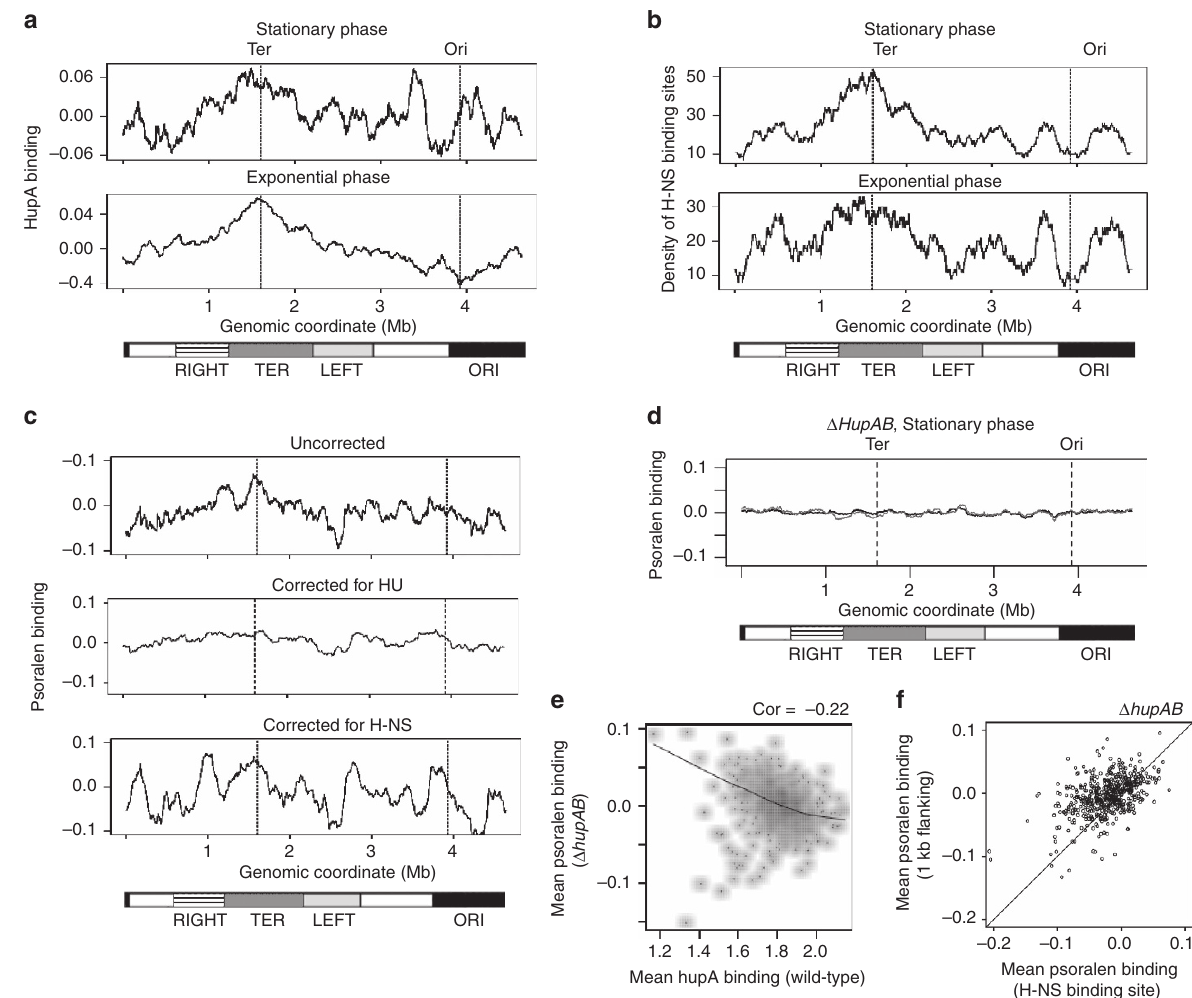
Figure 4 | Role of H-NS and HU in maintaining the supercoiling gradient. ( a ) HupA binding across the E. coli chromosome during stationary phase (upper) and exponential phase (lower). The moving average of the signal is plotted with a window size of 200Kb. ( b ) Number of H-NS binding sites in a 200Kb sliding window across the E. coli chromosome during stationary phase (upper) and exponential phase (lower). ( c ) Plot of psoralen binding across the chromosome, uncorrected (upper), corrected for the effect of HU (middle), and corrected for the effect of H-NS (lower). ( d ) Psoralen binding in the HU knockout strain during stationary phase. Black and grey tracks represent two independent replicates. The moving average of the signal is plotted with a window size of 200Kb. For ( a – d ) dashed lines mark the positions of the terminus and origin of replication, and lower bars represent chromosomal macrodomains. ( e ) Smoothed scatter plot of average psoralen binding in the HU knockout versus average HupA binding in the wild-type, in 5Kb bins covering the entire genome, during stationary phase. Black line represents loess fit. ( f ) Scatter plot of average psoralen binding in H-NS binding regions versus 1Kb flanking regions, in the HU knockout during stationary phase. Black line has slope ¼